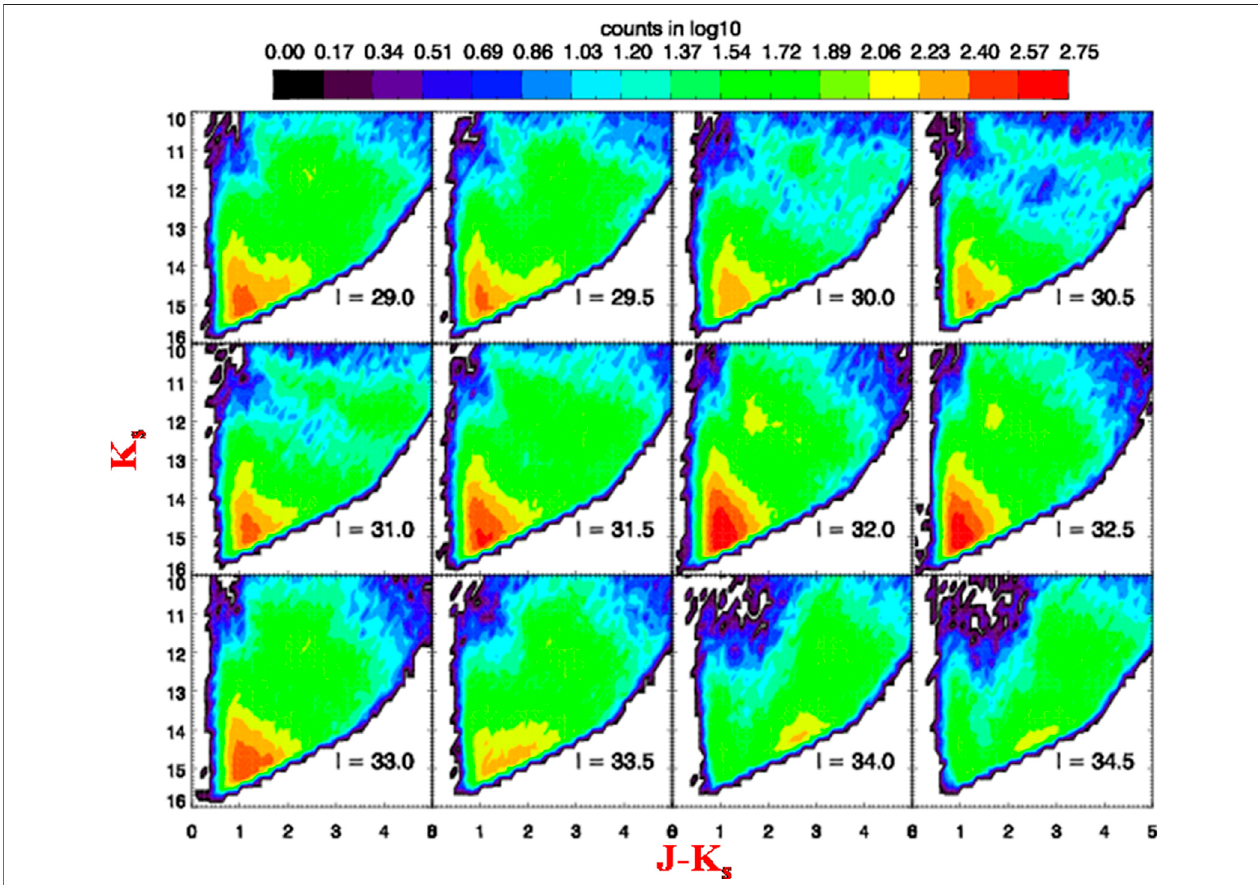
FIGURE 5 | Color-magnitude diagrams for Galactic longitudes from ℓ (cid:1) 29 ° – 34.5 ° .The Galactic longitudes ( ± 0.250 ° ) are shown in each panel.